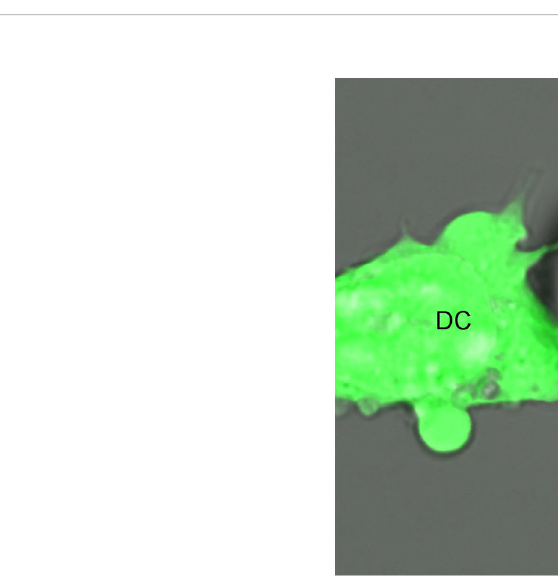
FIGURE 1 A dendritic cell (DC) extends its dendrites into a neighboring keratinocyte (KC), potentially for the purpose of intracellular